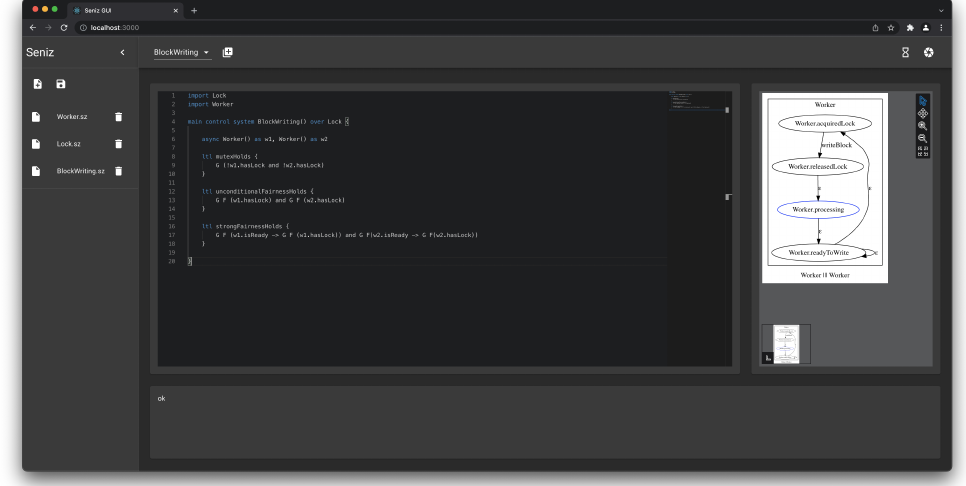
Figure 8. A snapshot of the Seniz web-based